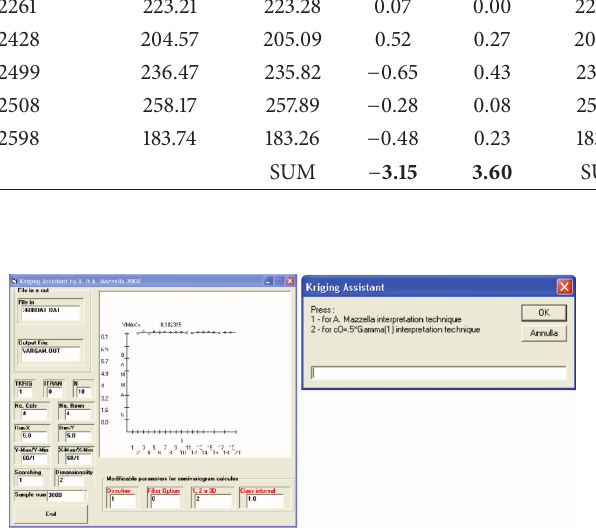
Figure 19: KA evaluation graphical results: on the left the “block map”and on the right the “contour